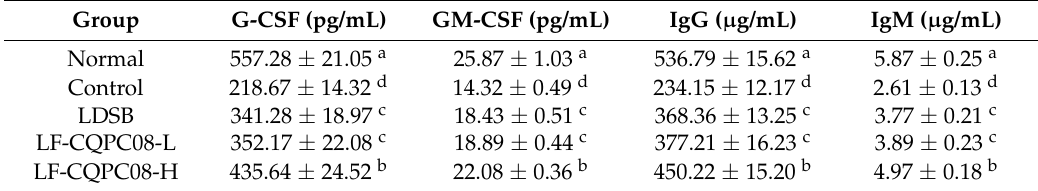
Values presented are the mean ± standard deviation (N = 10/group). a–d Mean values with different letters in the same row are significantly different ( p < 0.05) according to Duncan’s multiple-range test. LDSB: mice treated with 4NQO and Lactobacillus delbruechii subsp. bulgaricus (1.0 × 10 9 CFU/kg); LF-CQPC08-L: mice treated with 4NQO and Lactobacillus fermentum CQPC08 (1.0 × 10 8 CFU/kg); LF-CQPC08-H: mice treated with 4NQO and